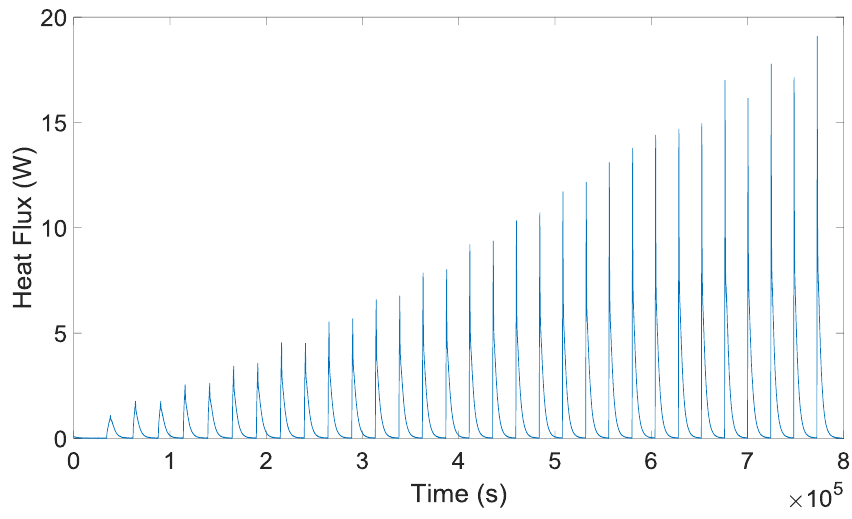
Figure 10. Heat flux variations of 13 Ah Altairnano battery cell.